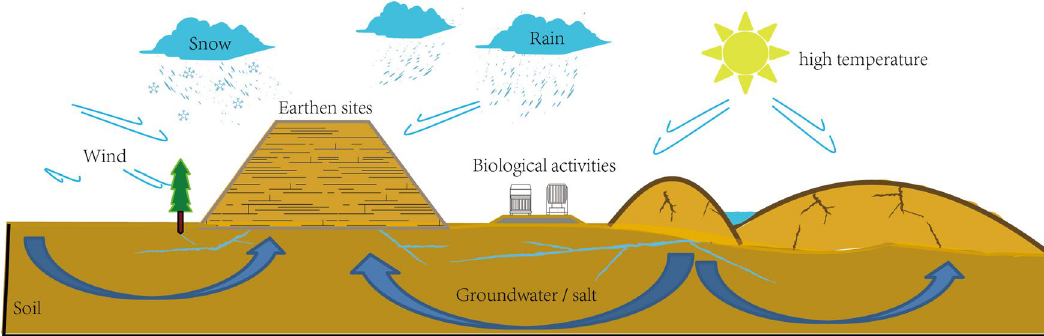
Figure 1. Schematic diagram of multi factor action of earthen sites.